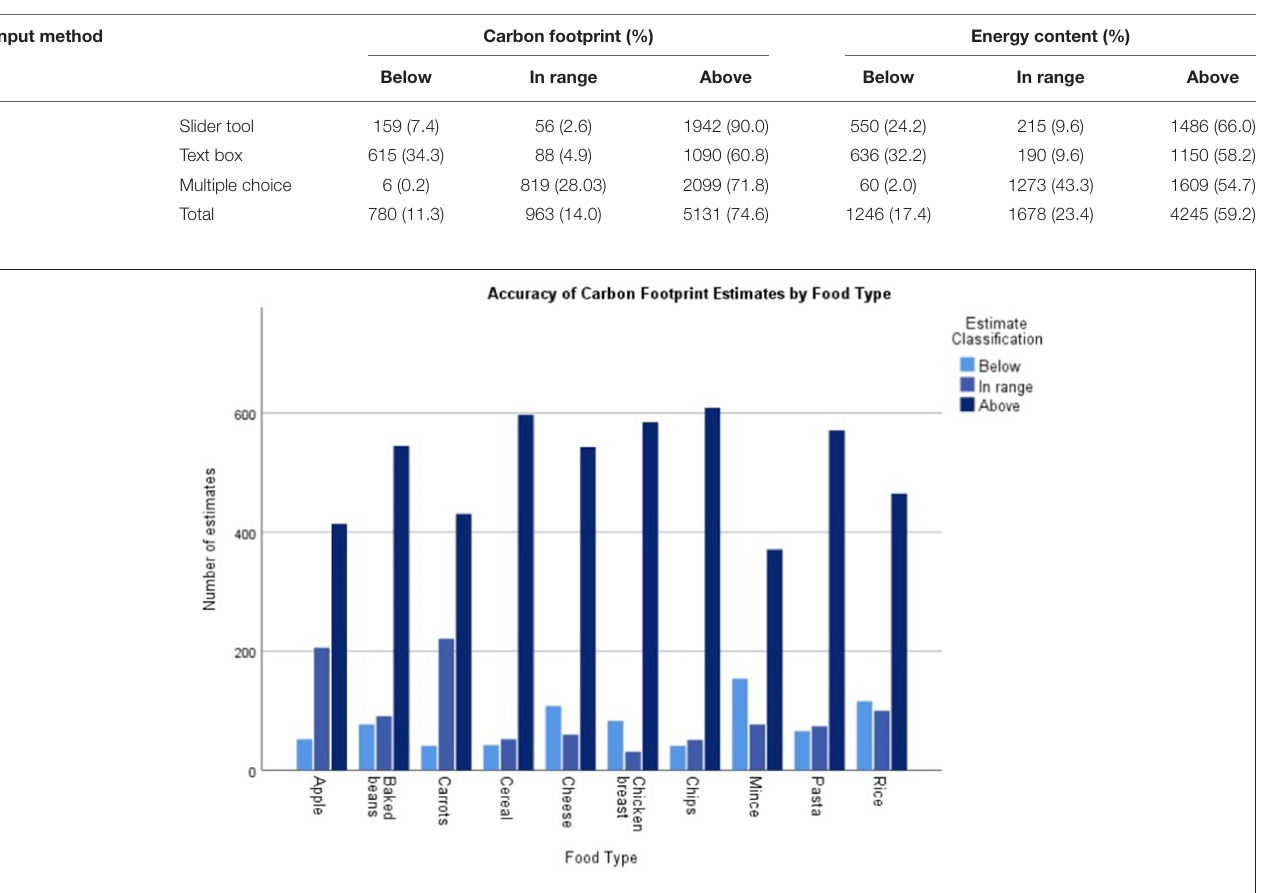
FIGURE 2 | Accuracy of carbon footprint estimates for each food